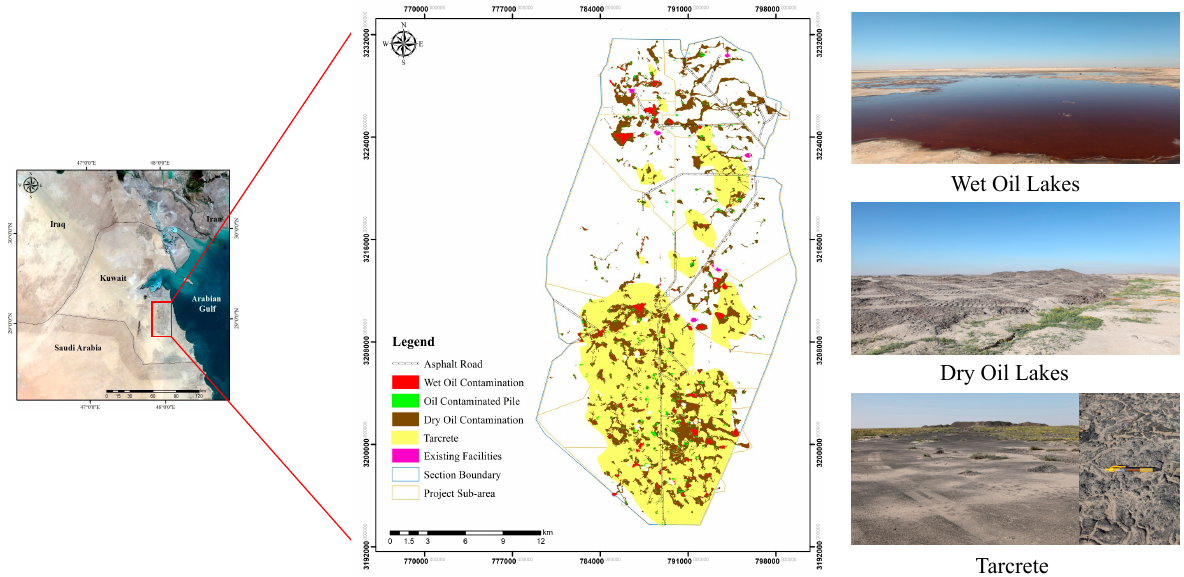
Figure 1. Al-Burgan oil field in southeast Kuwait, showing different types of hydrocarbon contamination: tarcrete, dry oil lakes, and wet oil lakes (KOC, 2019).